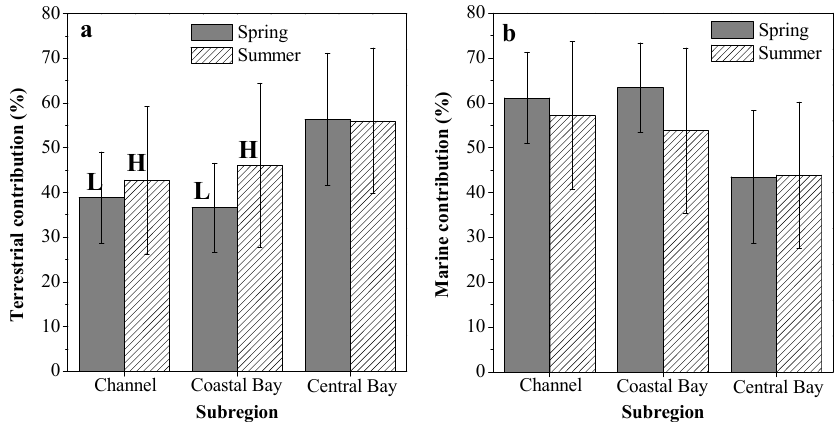
Figure 7. Source contributions of terrestrial ( a ) and marine ( b ) organic matter for the surface sediments in different subregions of Zhanjiang Bay. Different capital letters in Figure 7a indicate obvious seasonal variations with average seasonal differences larger than 10%.